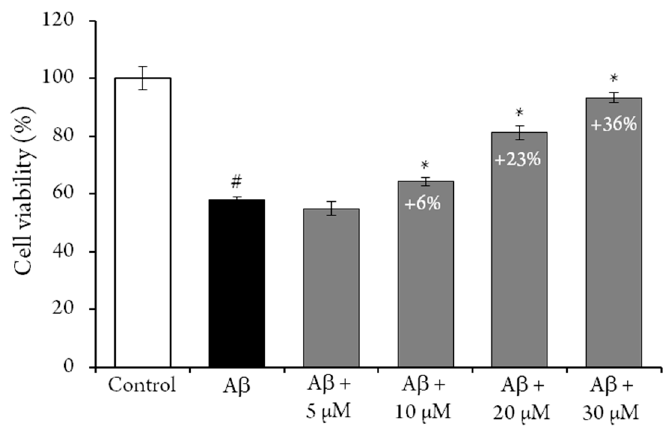
Figure 2. Cytotoxicity determination. PC12 cell viability was determined by the MTT assay. Cells were treated 24 h by the crown tetramer ( 1 ) in the presence or absence of 4 µ M of A β 25 − 35. Results are expressed as the mean SEM of four replicates (n = 4). # p < 0.05 A β 25 − 35 versus control, * p < 0.05 crown tetramer ( 1 ) versus A β 25 −